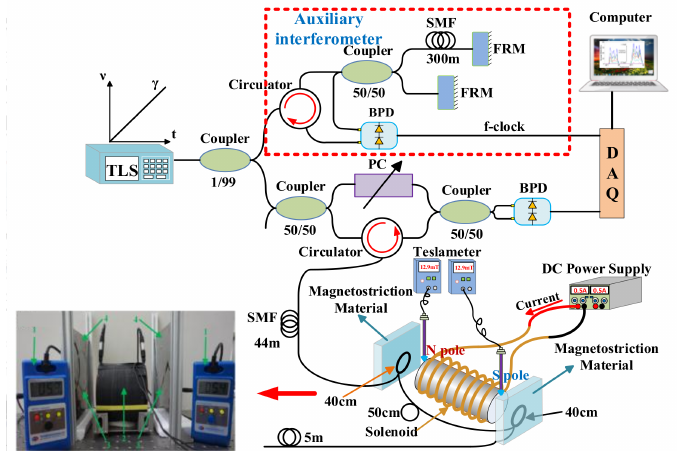
Figure 29. Experimental setup for distributed magnetic field measurement. TLS is tunable laser